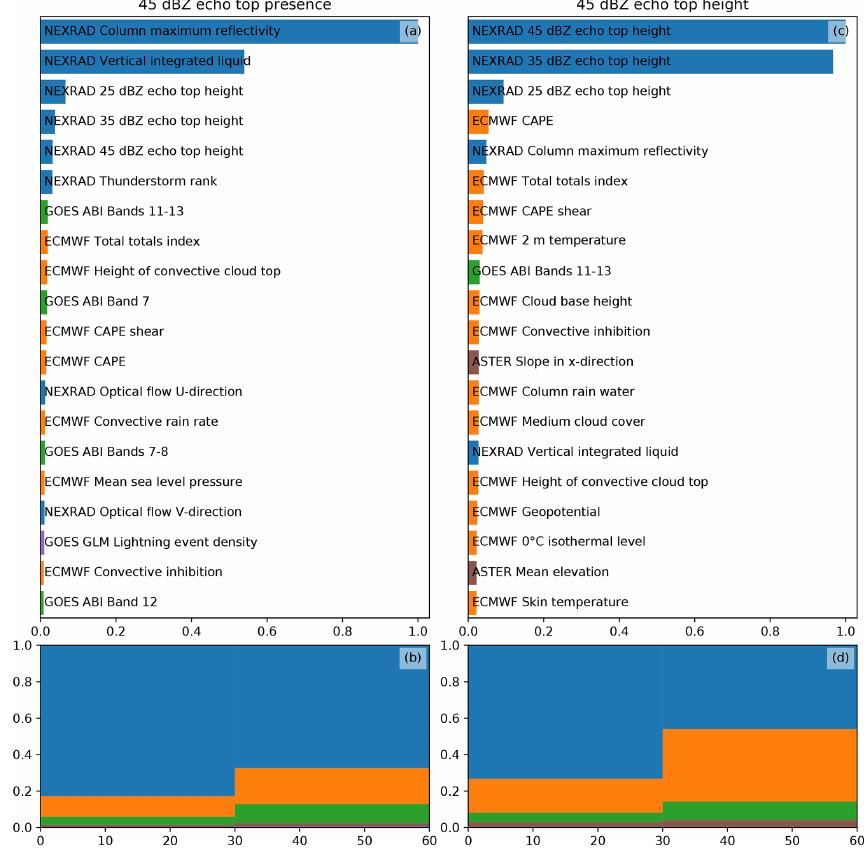
Figure 7. As Fig. 6, but for the ECHO45-OCC (a, b) and ECHO45-HT (c, d)